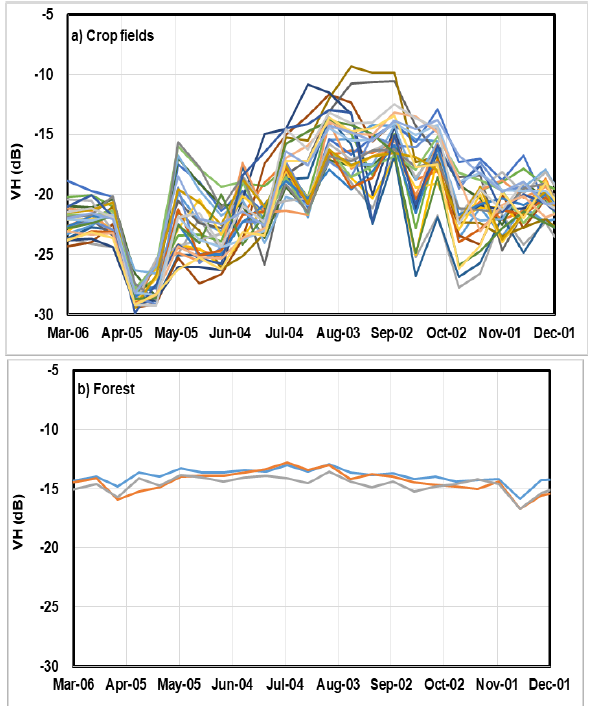
Figure 4. Typical seasonal variation of VV backscattering coefficients for the study area during May 6–December 1 2019, measured by Sentinel-1 C-band SAR. ( a ) crop fields and ( b ) forest.